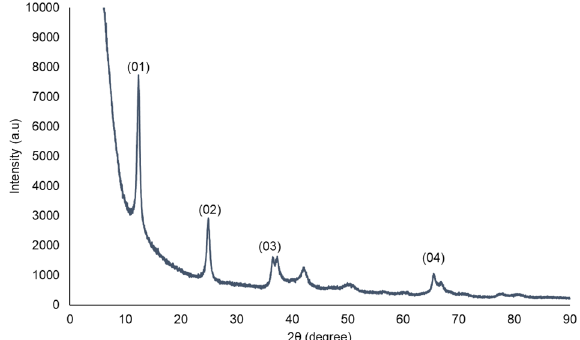
Figure 3. XRD pattern of synthesised MnO 2 .